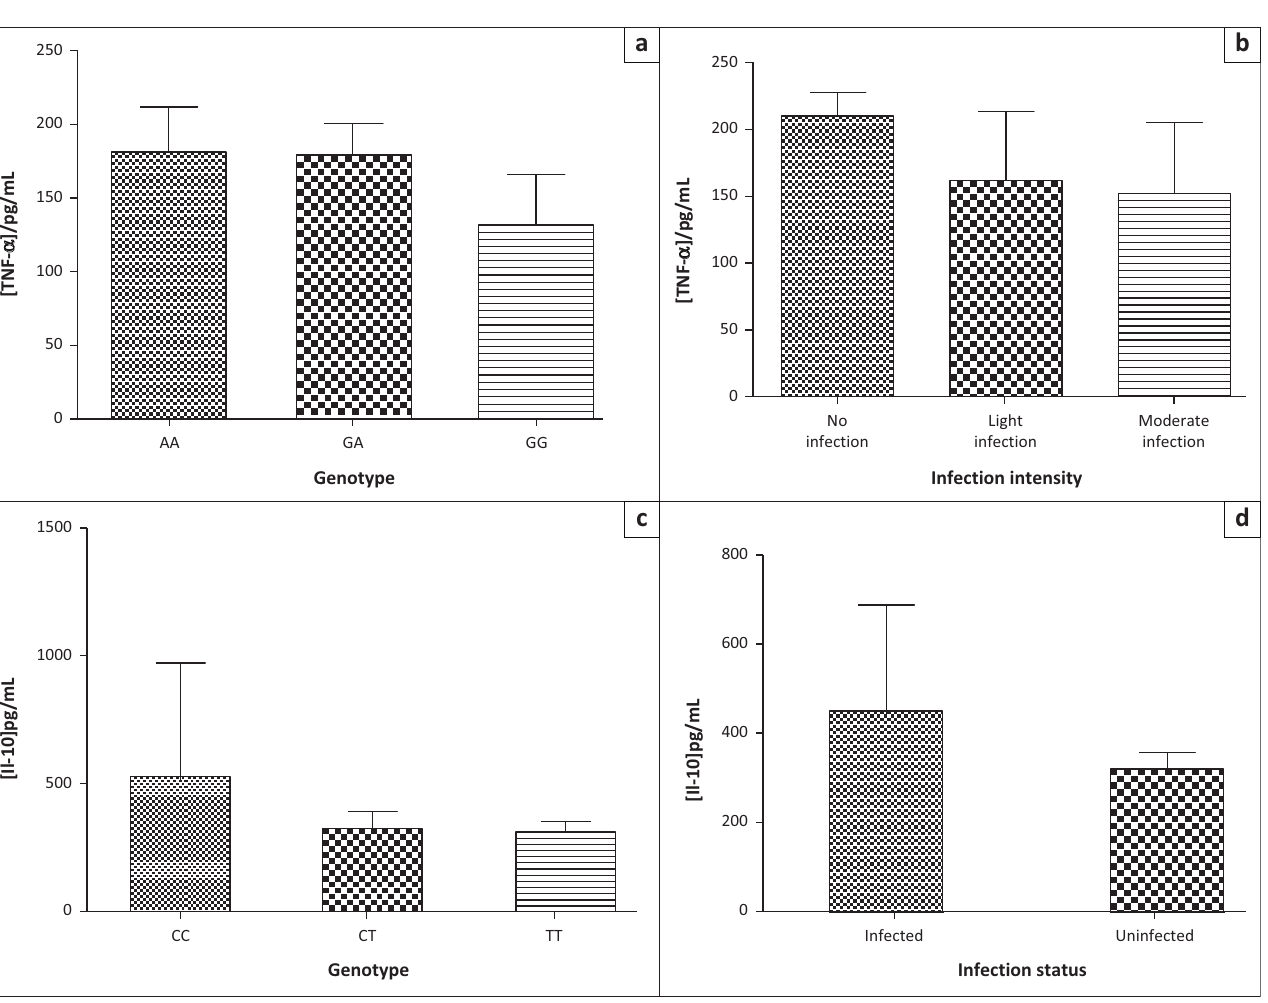
FIGURE 1: Genotypes, cytokine levels and infection status in preschool children from Madziwa, Shamva district, Zimbabwe, September 2018. (a) Genotypes and TNF- α production (mean level for AA is 179.3 ± 31.2 pg/mL n = 34, GA is 176.8 ± 23.8 pg/mL n = 98 and GG is 131.6 ± 36 pg/mL n = 14); (b) TNF- α levels against infection intensity (239 ± 71.6 pg/mL n = 23 and 210 ± 17.6 pg/mL n = 286); (c) Genotypes against IL-10 plasma levels (CC – 528.5 pg/mL, CT – 323.8 pg/mL and TT – 309.4 pg/mL) (d) IL-10 plasma levels against infection status (452.5 pg/mL and 376.4